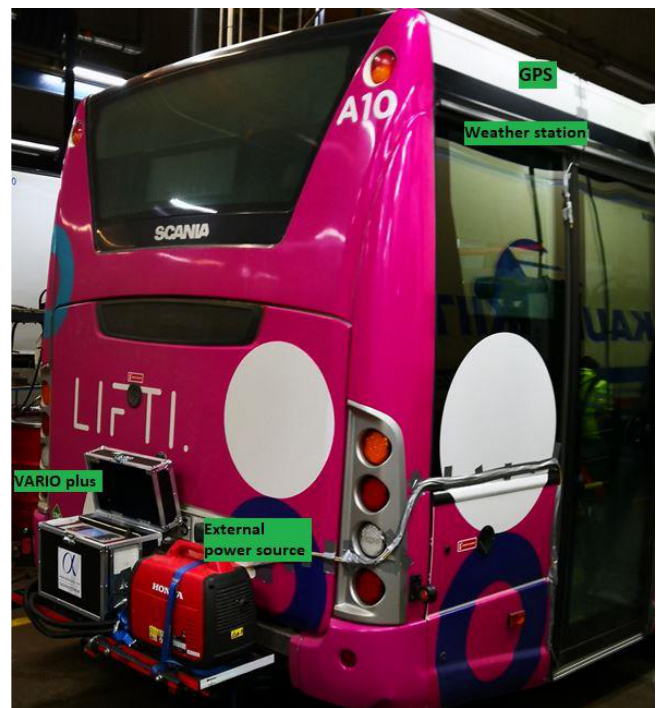
Figure 1. Measurement system set-up.